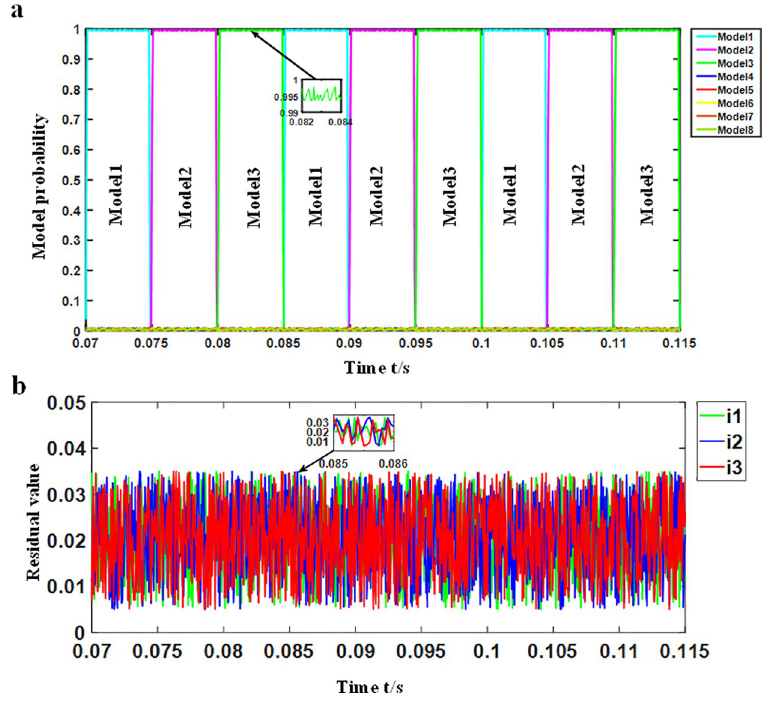
Fig 8. Simulation waveform under rated load. (a) Probability change waveform of each model (b) Current residual waveform of each.